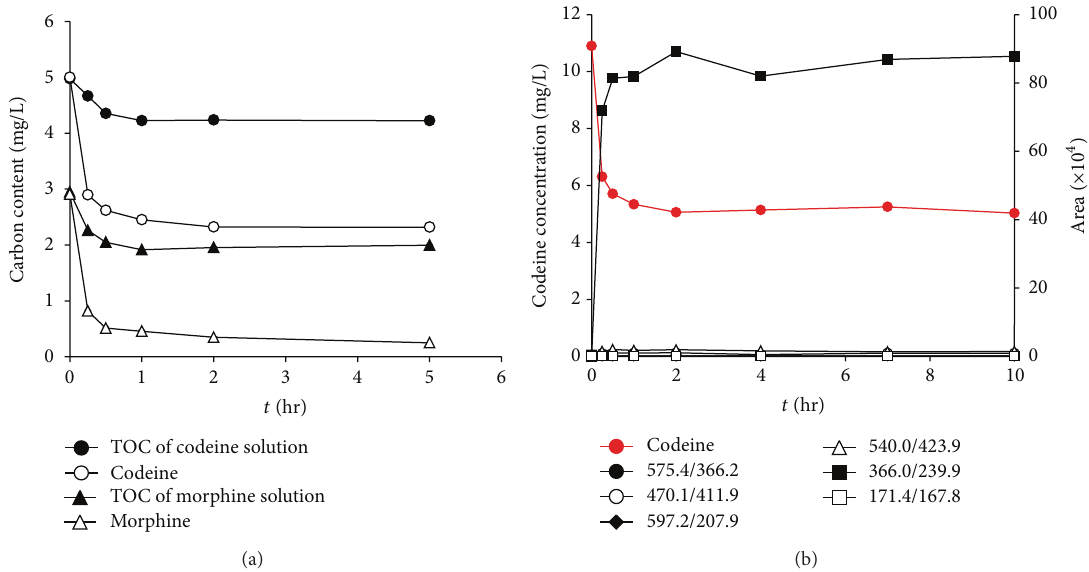
Figure 8: (a) Target compound degradation and TOC removal of codeine and morphine and (b) byproducts of codeine (MnO 2 = 8 mg/L, pH =